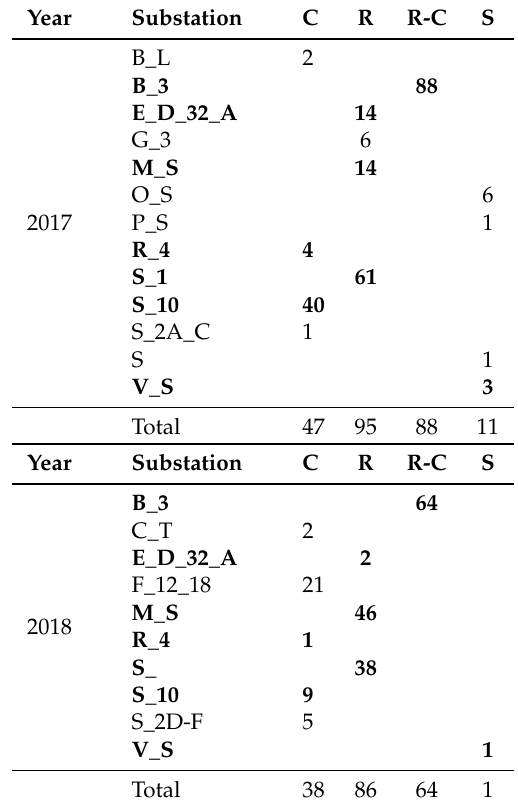
Table 6. Substations with bi-weekly deviating behaviours on an hourly basis and an overflow of more than 20 in 2017 and 2018.